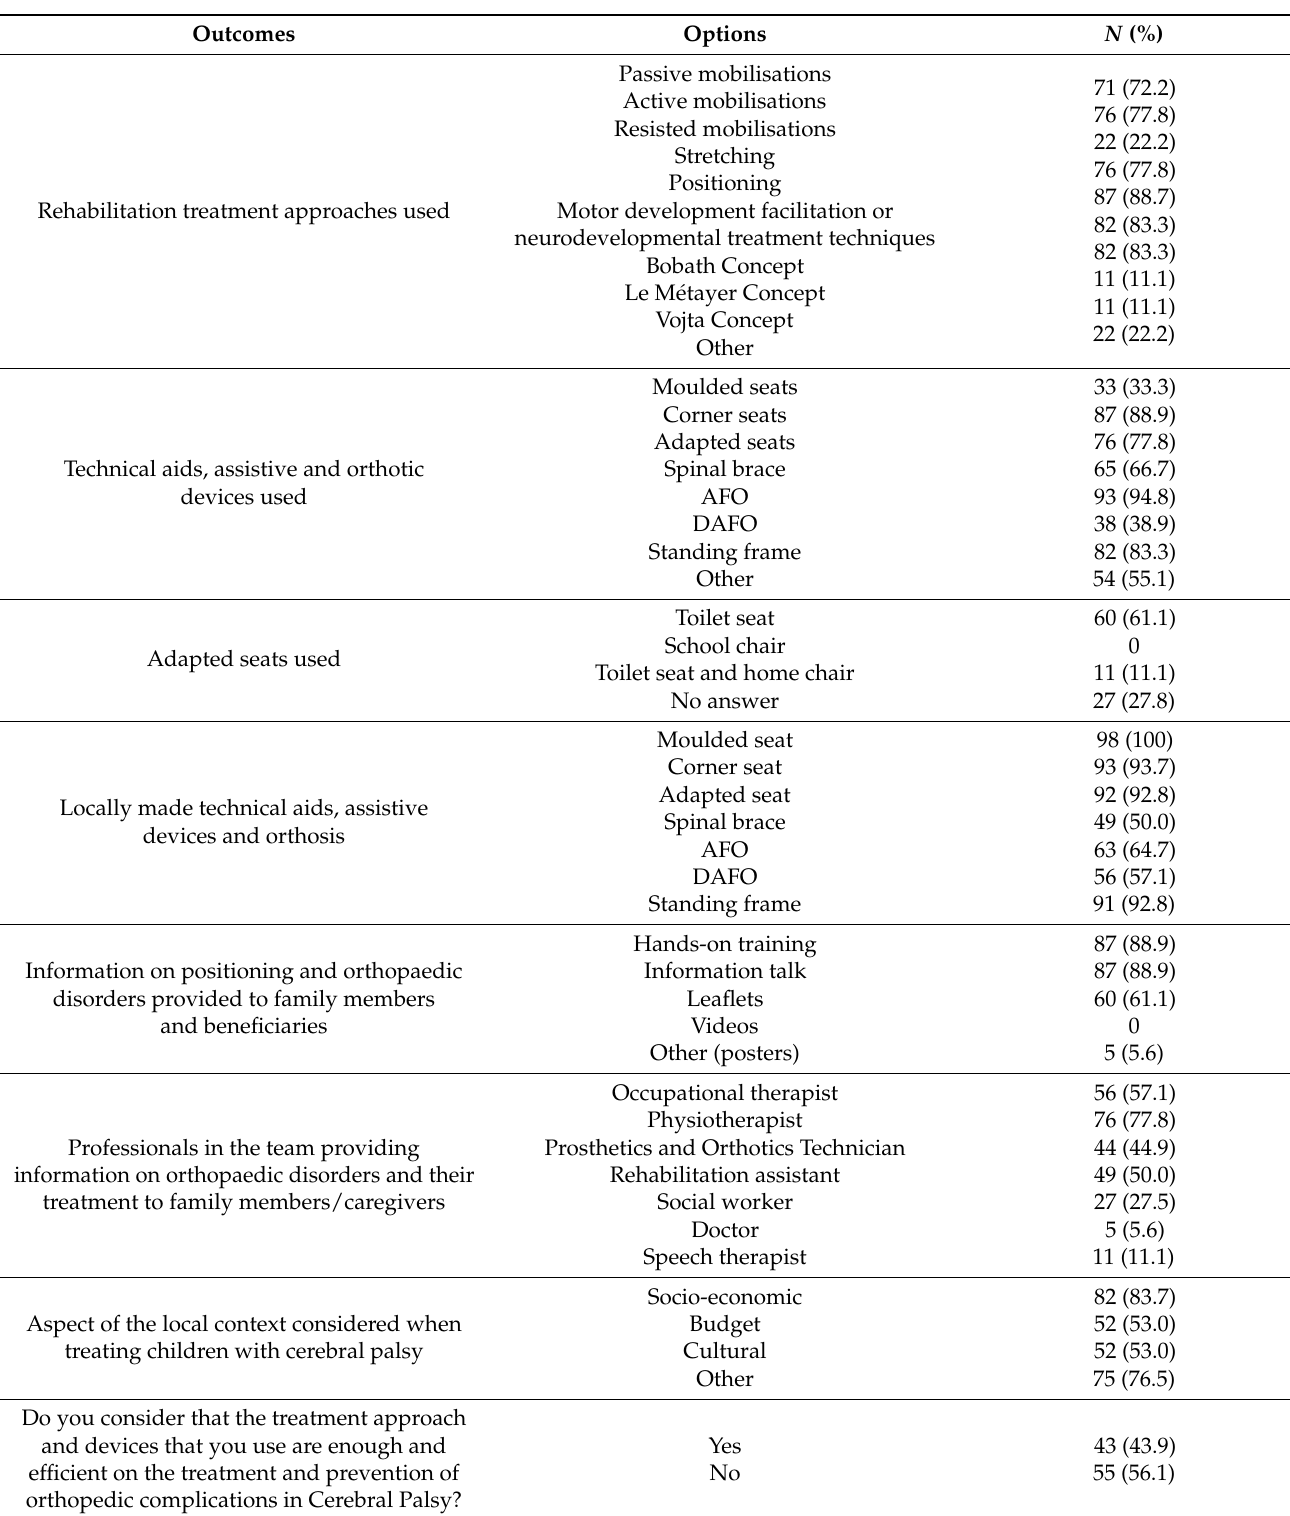
Table 3. Treatment approaches used for the management of cerebral palsy and its associated orthopaedic disorders in international cooperation